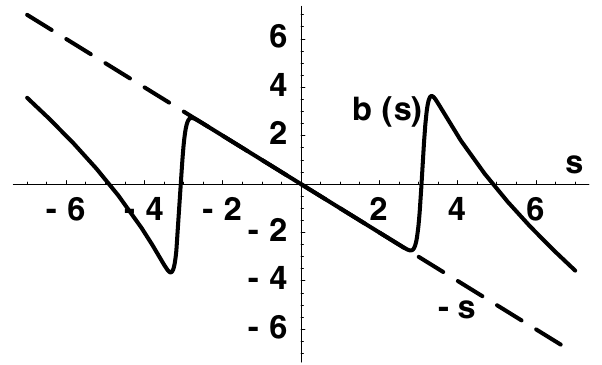
FIG. 19. The dimensionless velocity for the1D distribution of Fig. 18 (solid line), and for a harmonic oscillator (dashed line).